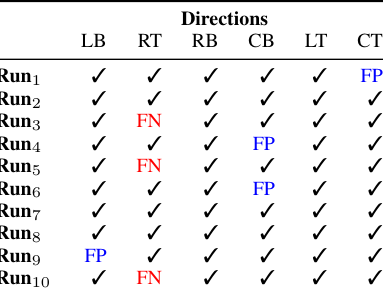
TABLE II S UCCESSFULLY SELECTED SECTIONS , FALSE POSITIVES (FP) AND FALSE NEGATIVES (FN) FOR THE LEFT HAND .